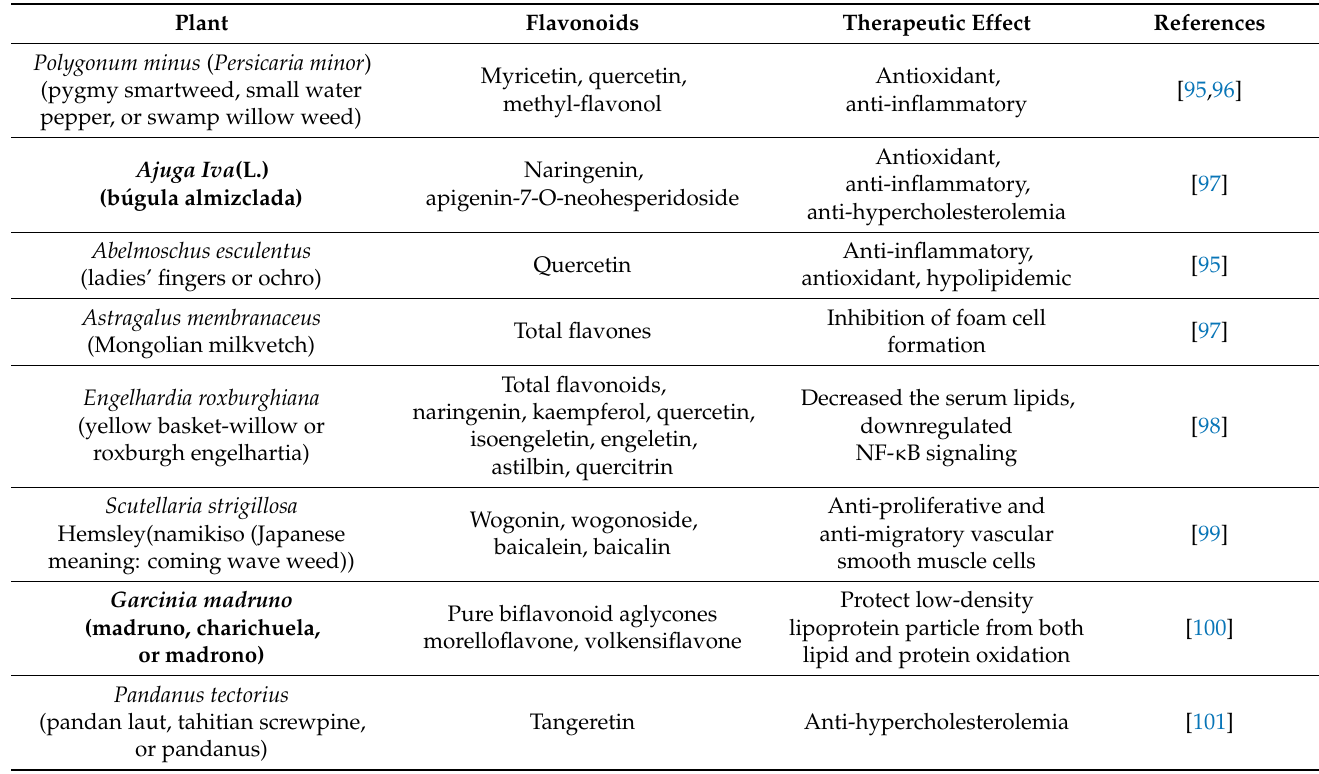
Table 2. Plants as natural sources of flavonoids with therapeutic effects for cardiovascular diseases and atherosclerosis treatment. Plant